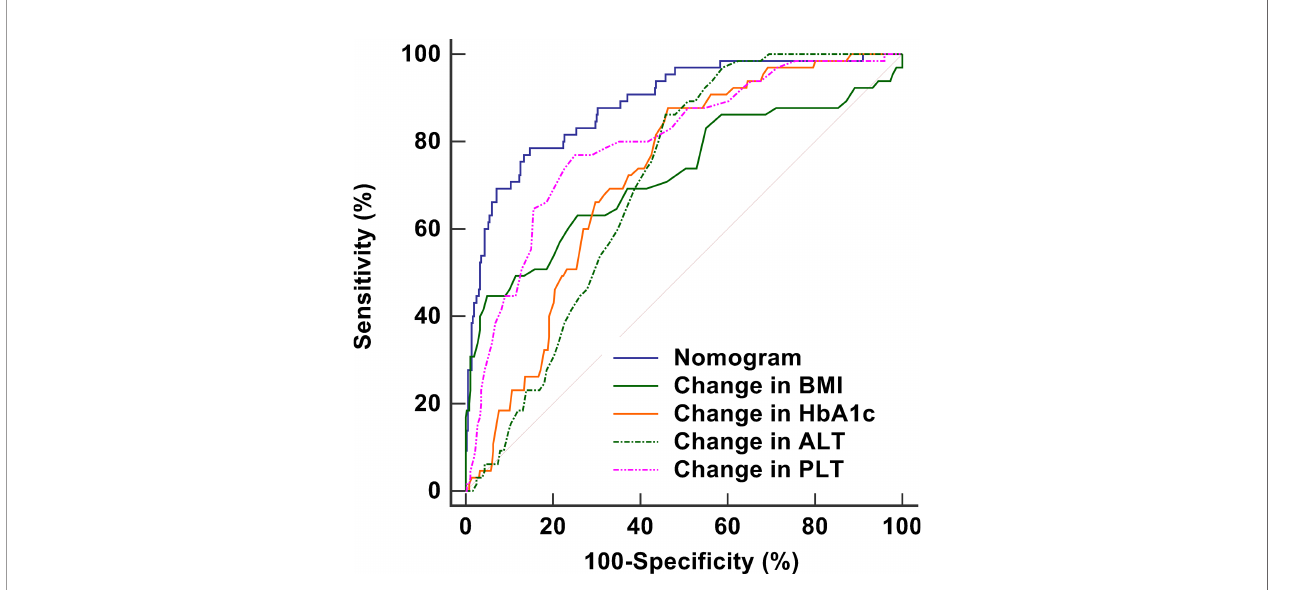
FIGURE 4 | ROC curves including nomogram and its components to assess the predictive accuracy of fi brosis progression. The AUC of the nomogram is 0.887, which is higher than the AUC values for changes in BMI (0.723), HbA1c (0.721), ALT (0.703), and PLT (0.797), demonstrating satis fi ed discrimination. ROC, receiver operating characteristic; AUC, area under the curve; BMI, body mass index; HbA1c, glycosylated hemoglobin A1c; ALT, alanine aminotransferase ratio; PLT, platelet